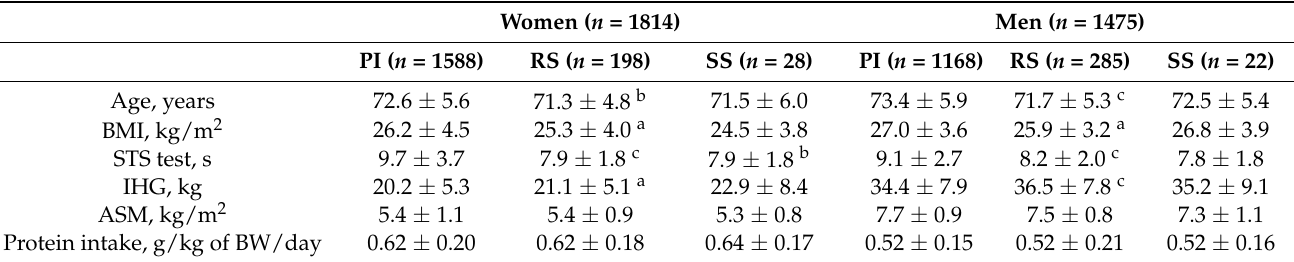
Table 1. Main characteristics of study participants according to sex and training groups ( n =